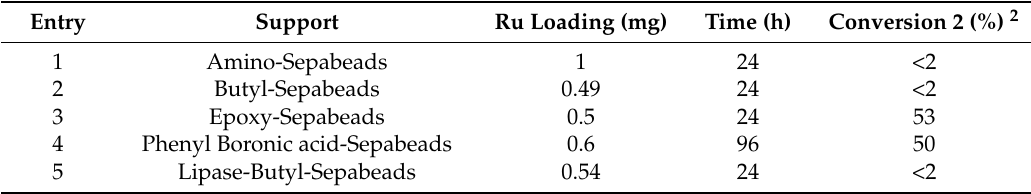
Table 2. Effect of the immobilization protocol on the catalytic capacity of Hoveyda–Grubbs second catalyst.